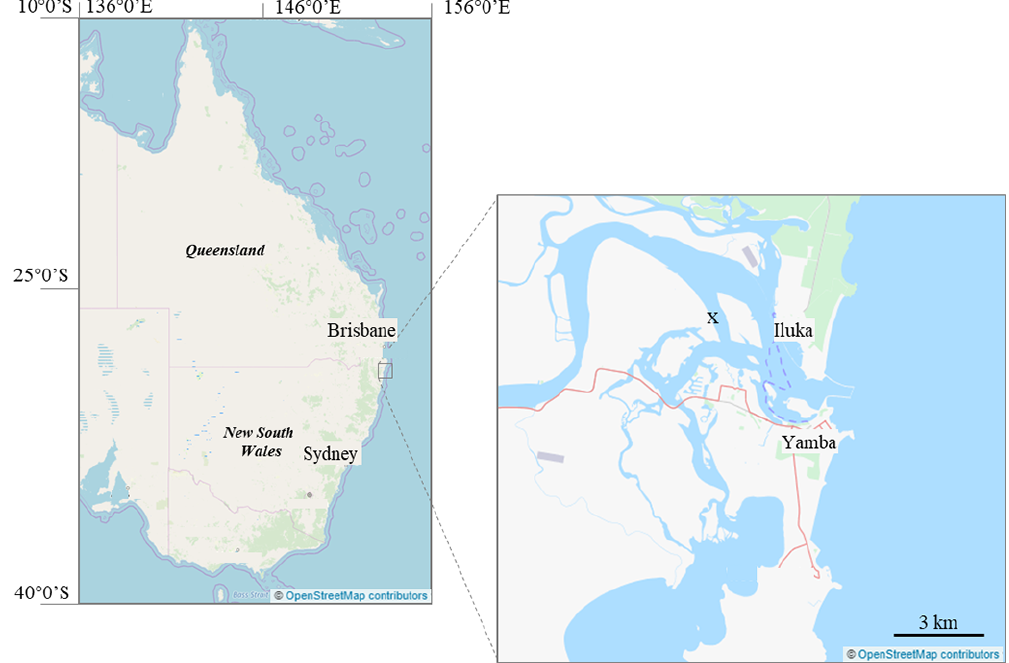
Figure 1. Study location (x; 29 ◦ 24.21 (cid:48) S, 153 ◦ 19.44 (cid:48) E) marked on a map of Yamba, NSW, embedded in an east coast map of Australia.